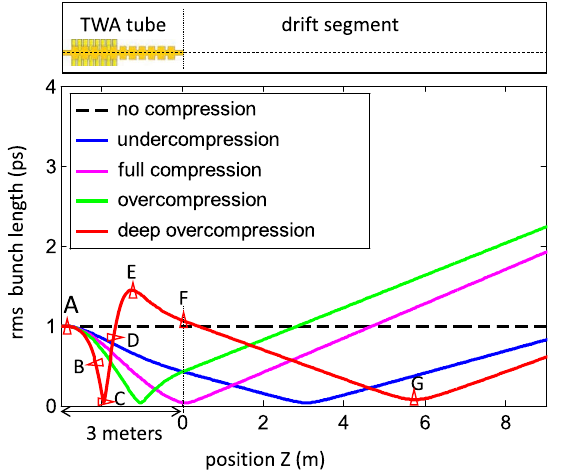
FIG. 4. Changes in rms bunch length along the beam line (position Z ) for different compression